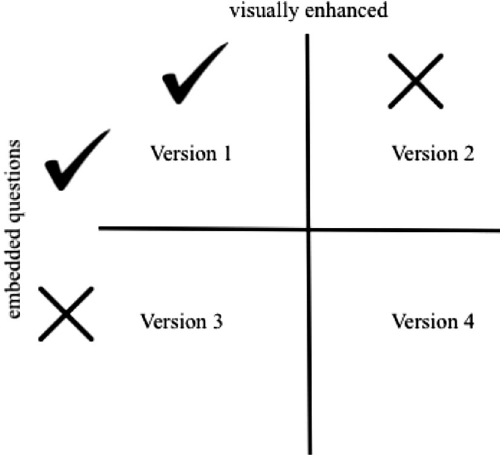
FIG. 1. Summary of four versions of videos used in the study.